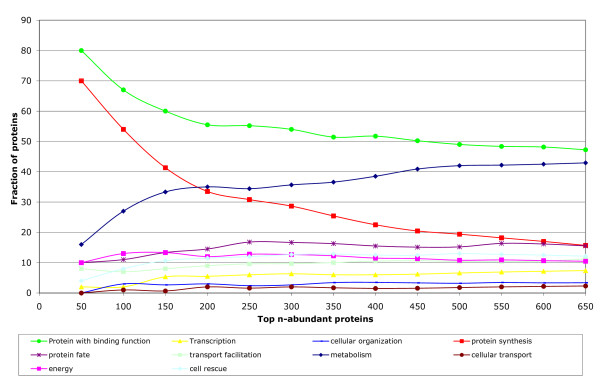
Abundance functional profile. Shown is the fraction of proteins which are involved in different functional categories in different abundance ranges. The first data point shows the functional breakdown of the 50 most abundant proteins, the second data point corresponds to the 100 most abundant proteins, and so on. Note that the fractions relative to the number of proteins (e.g. 50, 100...) do not sum up to 1 since a protein can have assigned multiple functions like protein synthesis and with binding function. The functional categories shown in the legend are the FunCat top level classifications as outlined in the Methods sections. In this plot all 1103 proteins – inclusive the 53 ribosomal proteins – are shown. Since the plot is based on relative ranking it is robust with respect to the observed copy number variability of these most abundant proteins.